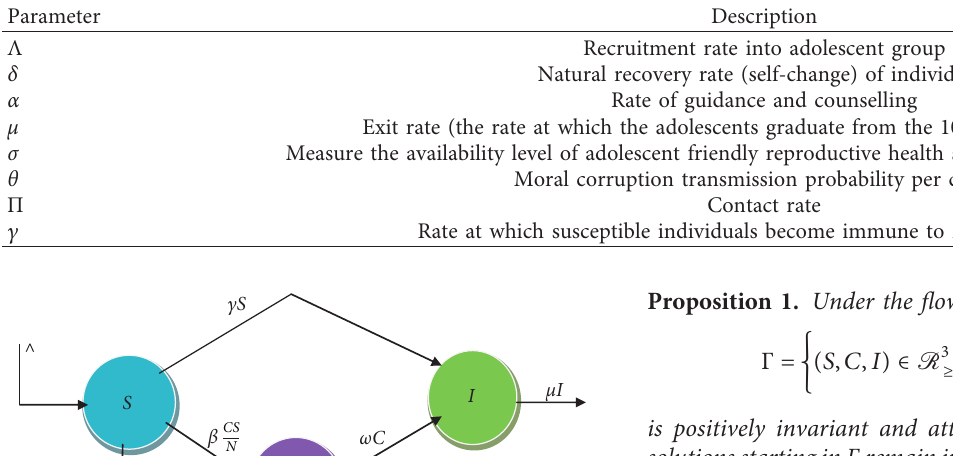
Table 1: Description of parameters of moral corruption model (1).